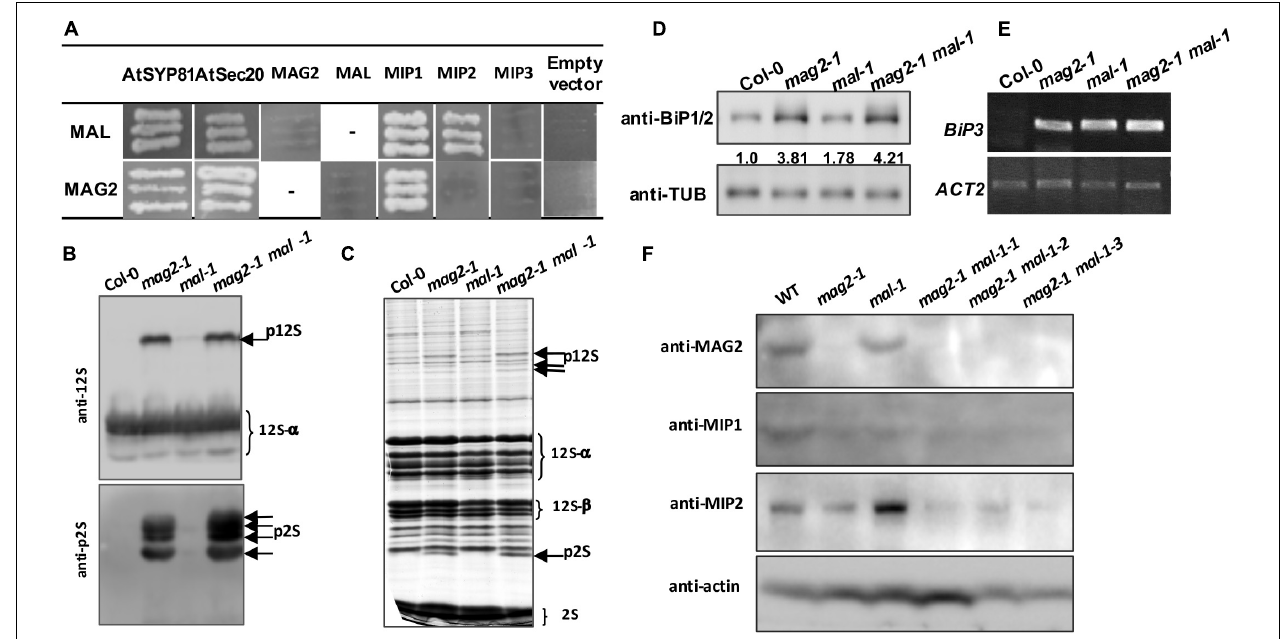
FIGURE 3 | MAG2 and MAL regulate protein export from the endoplasmic reticulum (ER). (A) Yeast two hybrid detection of MAL interactors. Detection of combinations of both MAL/pGADT7 and MAL/pGBKT7 with corresponding constructs was performed. AtSYP81 vs. AtSec20 served as positive control, whereas MAL/MAG2 vs. empty vectors served as negative control. − , Not performed. (B) Immunoblot detection of precursors of seed storage proteins. (C) Profile of whole seed proteins. (D) Immunoblot detection of BiP1/BiP2 proteins. Statistics of relative band concentration (presents protein abundance) is indicated in number below the bands (BiP/TUB, measured with ImageJ). (E) RT-PCR determination of BiP3 expression. (F) Immunoblot detection of MAG2, MIP1, and MIP2 in 7-day-old seedlings of indicated lines. 12S, 12S globulins; 2S, 2S albumins; p12S, precursors of 12S globulins; p2S, precursors of 2S